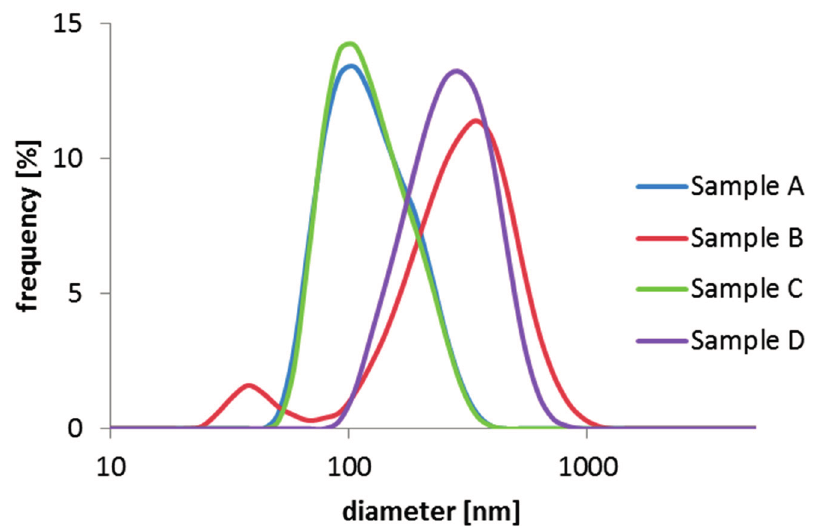
Figure 3. DLS size distribution by intensity of samples A, B, C, and D.